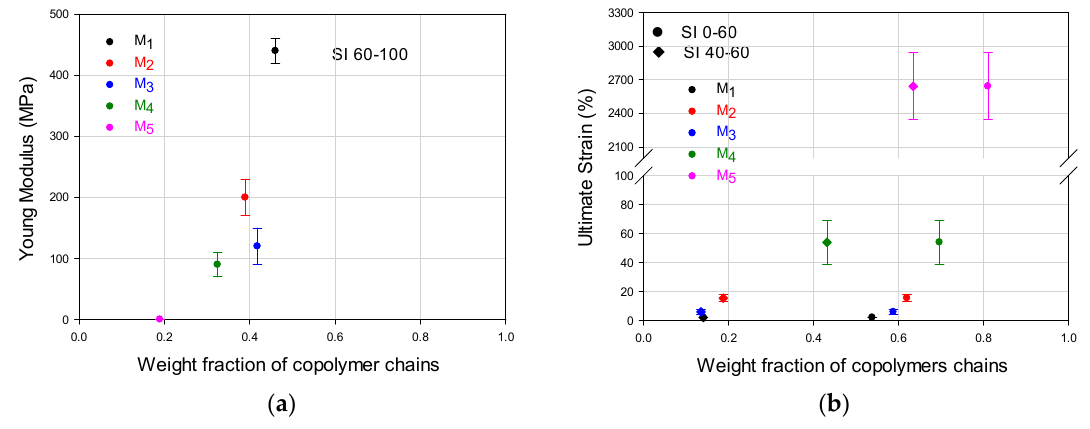
Figure 4. Young’s modulus and ultimate strain as a function of styrene weight fraction within FCCs at specific copolymer composition intervals. ( a ) Young modulus for SI 60–100; ( b ) Ultimate strain for SI 0–60 and SI 40–60. For FCCs codes, see Figure 1.